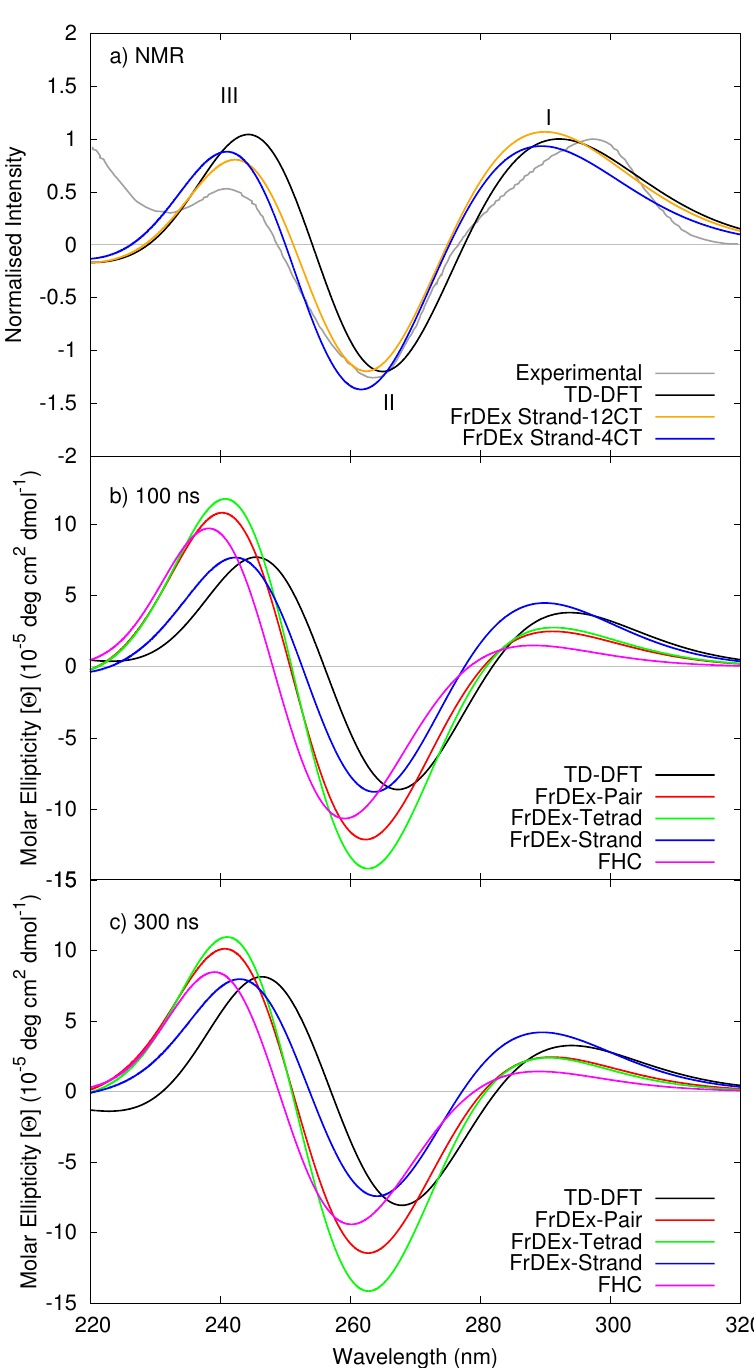
Figure 2. Computed ECD spectra of ( a ) Tel21 NMR structure by TD-DFT and FrDEx with 4 or 12 CT states, compared to experiment [59]. Panels ( b , c ) show computed spectra of Tel21 from MD snapshots at 100 and 300 ns, respectively, using TD-DFT and FrDEx with 4 CT states. All panels use pairs as the SC to calculate H inter , panel ( a ) uses a strand as SC to calculate H intra , whilst panels ( b , c ) use different sizes of SC indicated in the captions. In panel ( a ), the intensity of peak I is normalised to a value of 1 for both the experimental spectrum and the TD-DFT spectrum of the NMR structure, with the FrDEx spectra normalised using the same scaling factor as the TD-DFT spectrum. The spectra in panels ( b , c ) are not normalised. All calculated spectra are shifted by − 0.85